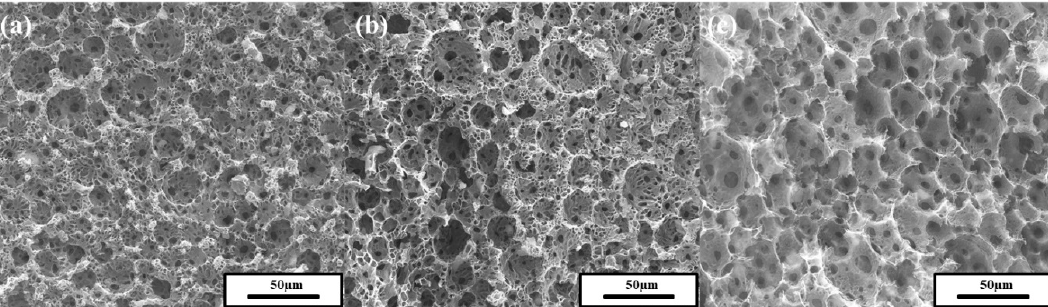
Figure 9. SEM images of polyHIPEs prepared with a 5 wt.% oligoimide particle concentration and 6 wt.% PAAS concentration with internal phase values of ( a ) 75 vol.%, ( b ) 80 vol.%, and ( c ) 85 vol.%.